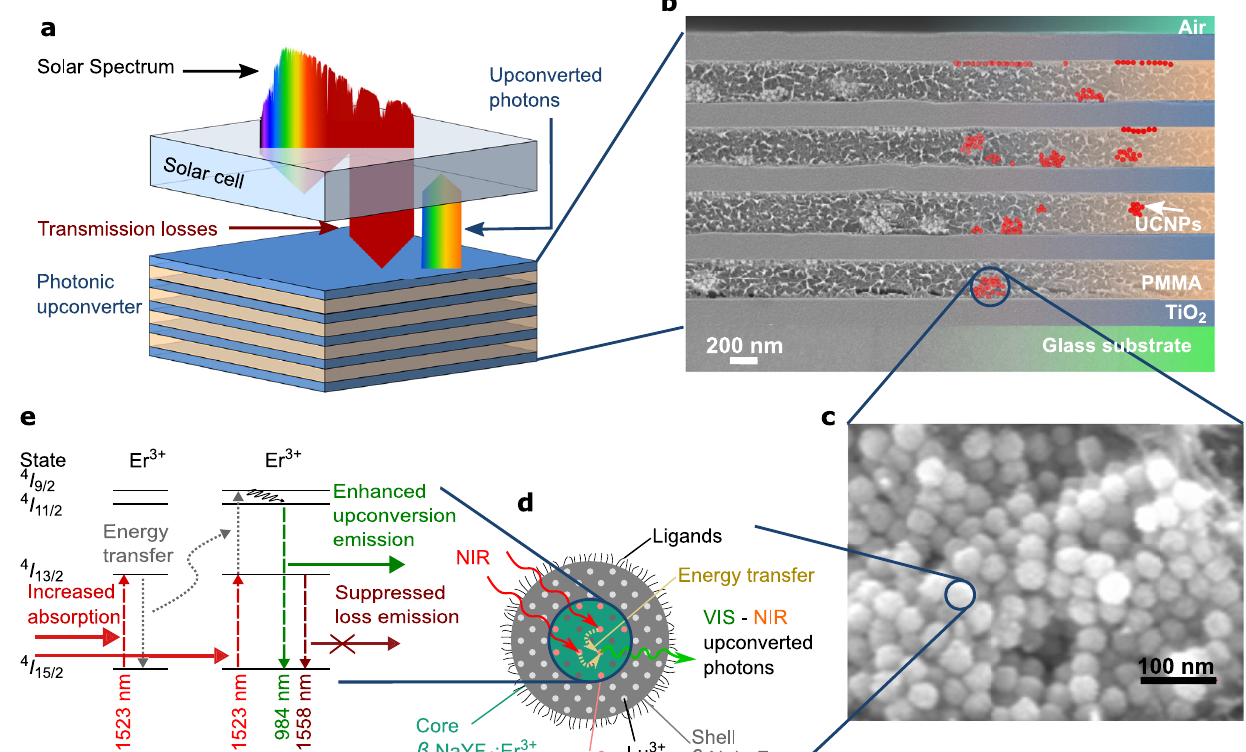
Fig. 1 Motivation of the investigated photonic upconverter device. a Approach of utilizing sub-bandgap photons for charge generation in a solar cell by a photonic upconverter on the rear side. b Scanning electron microscope (SEM) image of the realized 1D-photonic structure made of TiO 2 and PMMA with embedded upconverter nanoparticles (UCNPs). c SEM image of upconverter nanoparticles. d Schematics of core-shell upconverter nanoparticles of NaYF 4 : Er 3 + , converting near infrared (NIR) to NIR and up to visible (VIS) photons in the active core. The inert shell prevents losses due to surface quenching. e Energy levels in the upconverter Er 3 + and the upconversion (UC) process in fl uenced by photonic effects of the surrounding structure: increased absorption due to a locally enhanced energy density, non-linearly increasing the probability of an energy transfer UC process, followed by UC emission from a higher level that can be enhanced due to a modi fi ed local density of optical